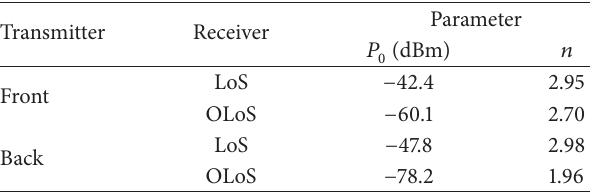
Table 1: Propagation model parameters, pine forest.